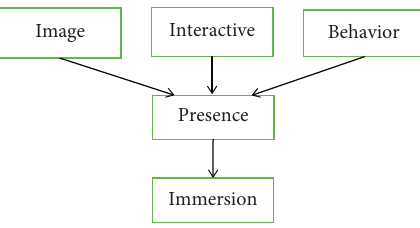
Figure 4: VR technology elements and characteristics.